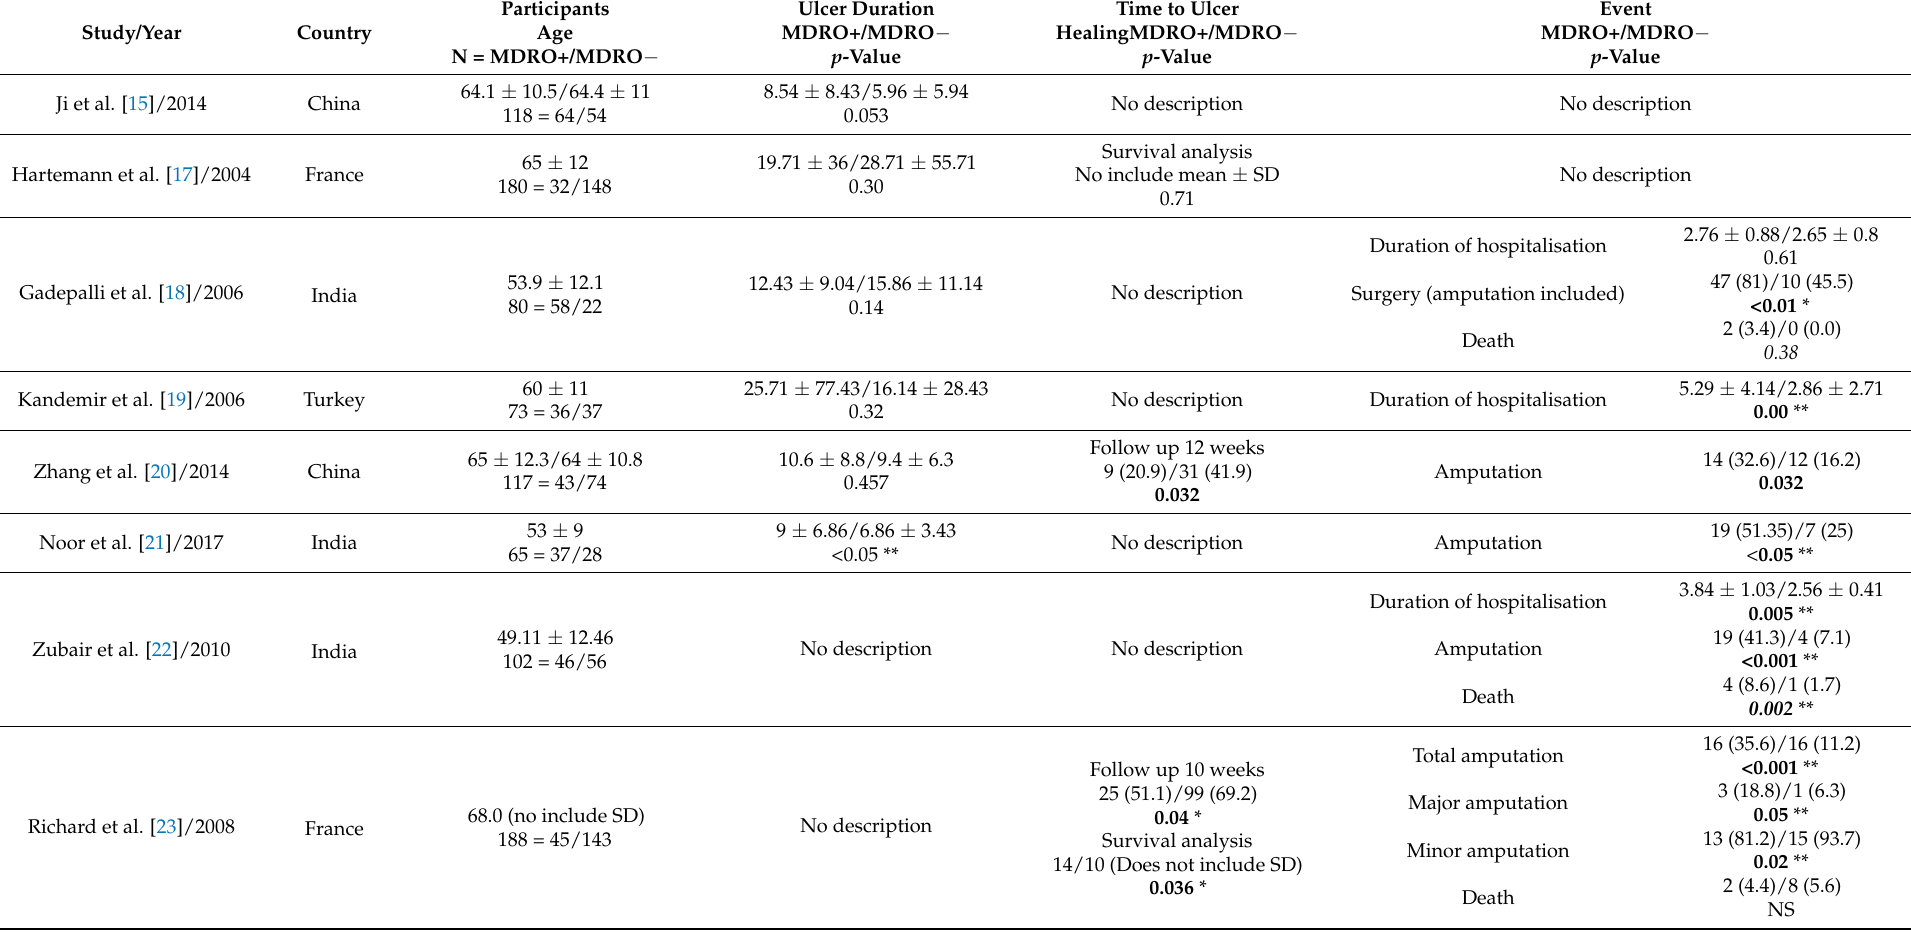
Table 3. Characteristics of the studies that were included in the systematic